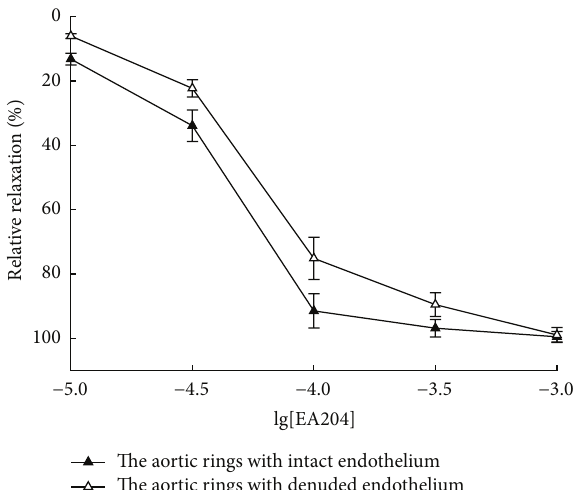
The aortic rings with intact endothelium The aortic rings with denuded endothelium Figure 2: Concentration-response curves for EA204 in rabbit aorta withandwithoutendothelium.Aorticringswereprecontractedwith phenylephrine (1 𝜇 M). Endothelium was removed mechanically by rubbing with a steel wire. Responses are expressed as a percentage of the maximum possible relaxation, that is, relaxation back to the baseline tension. Values indicated the means ± SEM ( 𝑛 = 8 ).